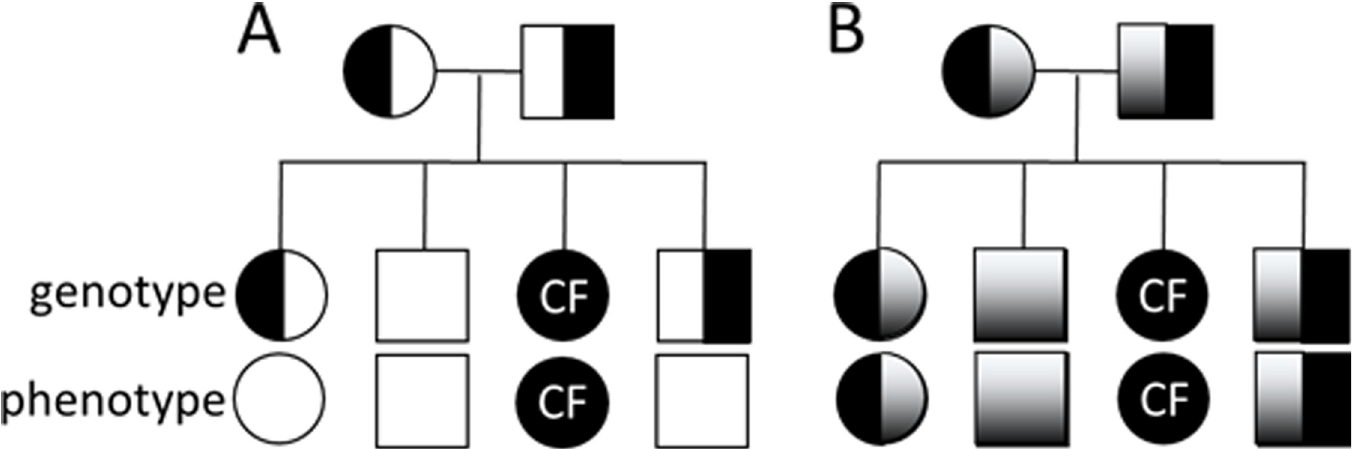
Fig 1. Inheritance probabilities for a monogenetic disease. A . Traditional diagram of inheritance probabilities for a monogenetic disease like CF in a family where both parents are carriers. Each child has an equal chance of getting the CF allele, so on average half the children are carriers, ¼ are not carriers, and ¼ have the CF phenotype. This works for phenotypic traits that are not rate-limited by the gene product, so that the carrier phenotype is unaffected, giving on average ¼ affected offspring. B . Ranges of phenotypic traits that are rate-limited by the gene that causes disease when both alleles are mutated. Unaffected individual show a range of function and carriers have half of that. For simplicity, a single range of function is shown. White is full function, black is zero function, gradient is intermediate function. CF is a recessive disease in which some traits are rate-limited by the gene product and are therefore ‘semi-dominant’. So far, very few physiological measures are known to be rate-limited by CFTR; these include β -sweat secretion and bicarbonate secretion in the